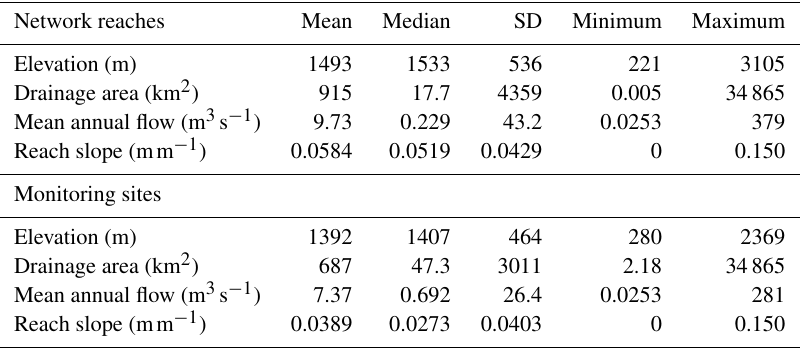
Table 1. Descriptive statistics for spatial attributes of the study network and 226 monitoring sites with annual temperature data in the northwestern United